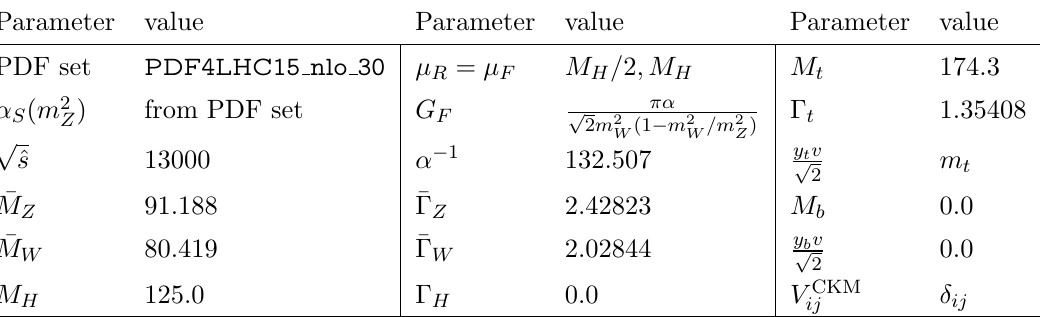
q (cid:22) M 2 i (cid:22)(cid:0) W (cid:22) M W . The collision energy is set W (cid:0)